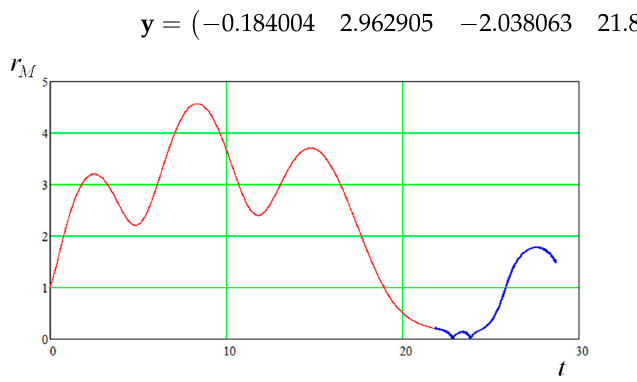
Figure 23. Selenocentric distance r M [undim.] along the full flight trajectory of the spacecraft. The area of “circumlunar” motion is marked in blue.